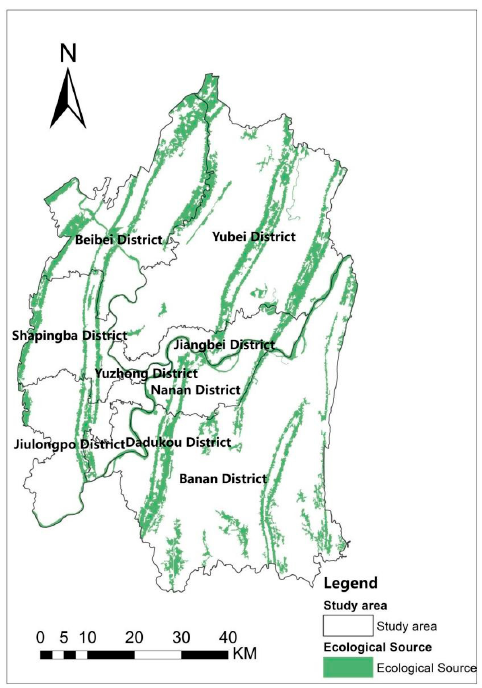
Figure 5. Ecological source.